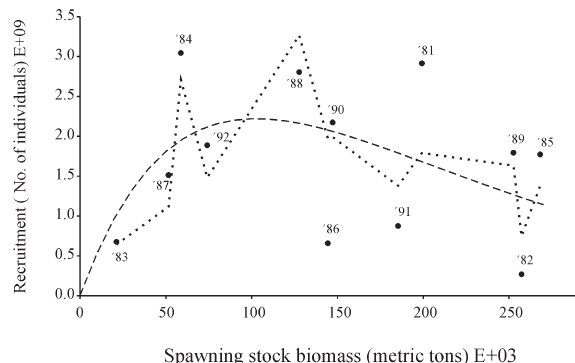
Fig . 2. – observed recruitments and recruitments calculated by us- ing ricker’s stock-recruitment function , with and without the en- vironmental effect, for the population of Pacific sardine in the area of Magdalena Bay. ( = ) observed recruitment (years 1981 to 1992); (- -) calculated recruitment, r=58883473 s e (-0.01 s) ; (…) calculated recruitment with Mei, r=83250670 s e (-0.011 s) e (-0.467 Mei) .